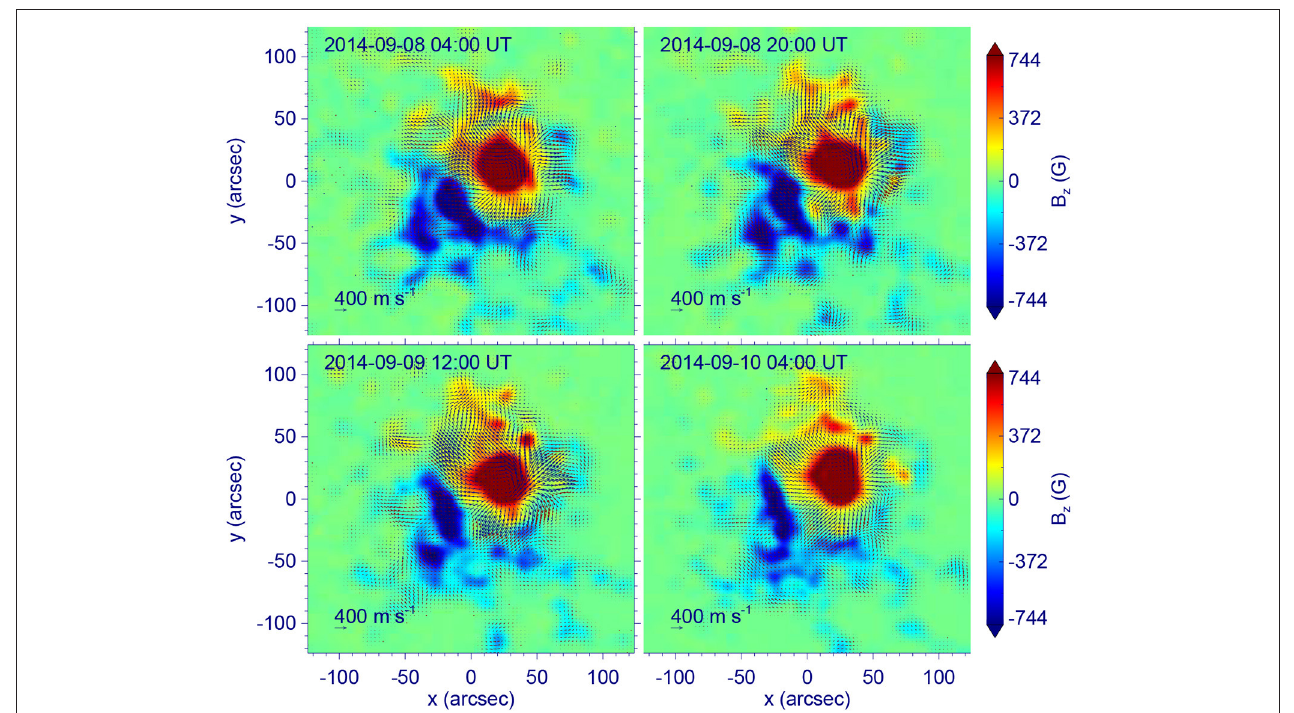
FIGURE 5 | Four snapshots of the surface flows (the final smoothed version) as derived using the DAVE4VM code.